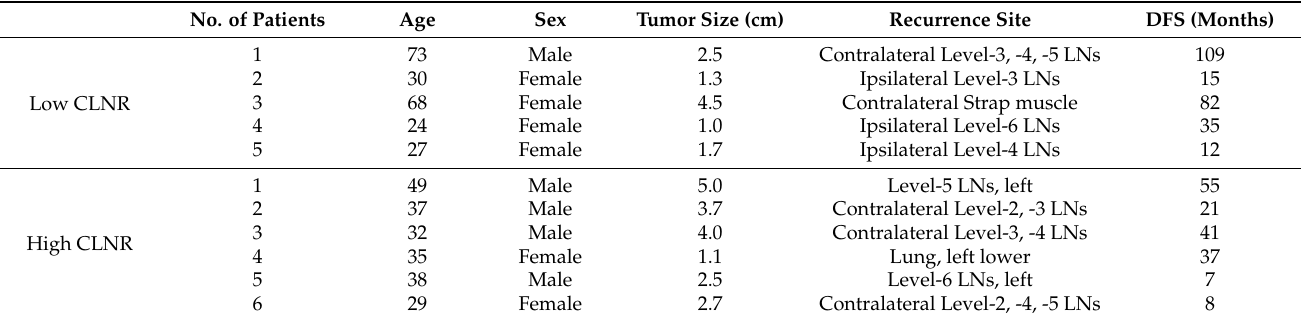
Table 5. Recurrence patterns for the study